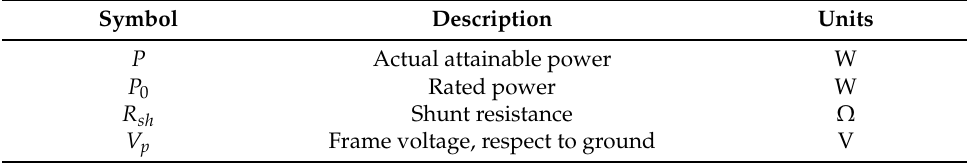
Table 1. Nomenclature for photovoltaic modules.